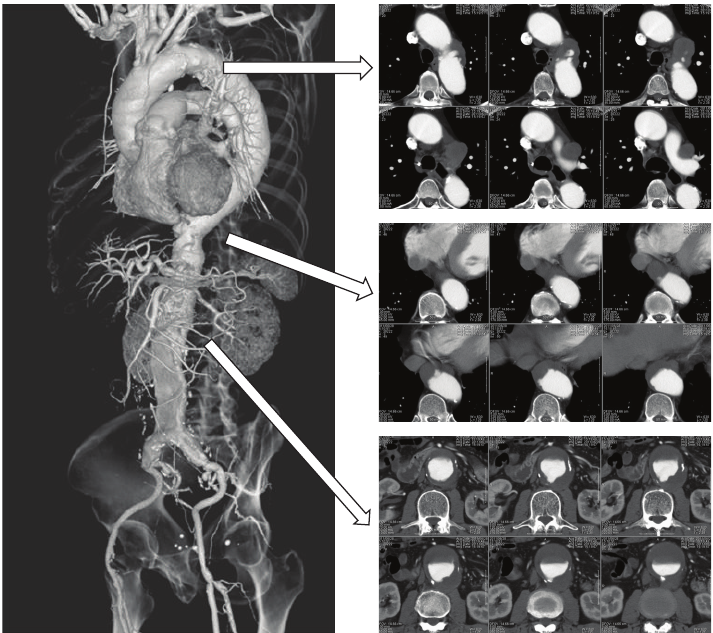
Figure 1: Contrast CT revealed an abdominal aortic aneurysm (anteroposterior diameter, 55 mm) with a partially protruded posterior wall, a saccular thoracic arch aneurysm, and an atheroma-rich “shaggy aorta”. Although clinical symptoms of bleeding tendency were not apparent, treatment of DIC was planned before